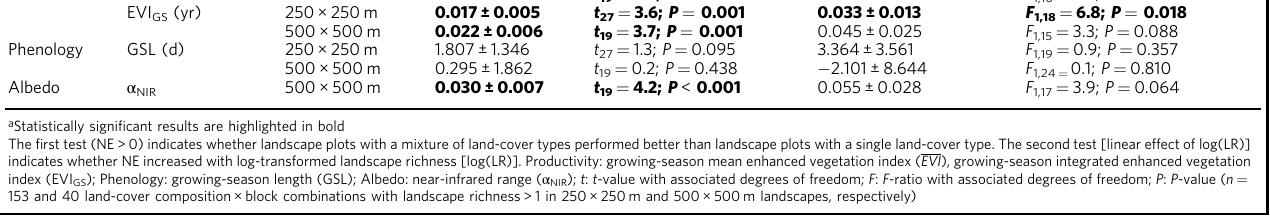
(LR) on inter-annual stability of growing-season length (CV (cid:1) 1 Fig. 3), land-surface albedo in the near-infrared (CV (cid:1) 1 α ) or total short-wave range (CV (cid:1) 1 α visible (CV (cid:1) 1 α vis Scale-dependence . The landscape richness – landscape functioning relationships we found were consistent between 250 × 250 m and 500 × 500 m plot sizes at which we assessed landscapes.